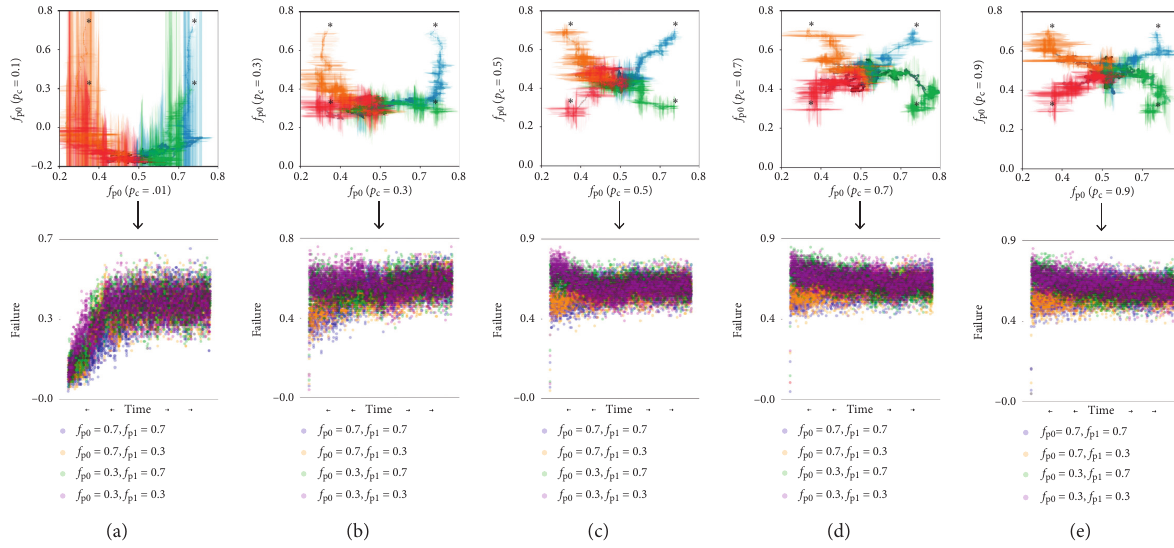
Figure 10: Patterns of evolution phenotypes obtained from the different starting point of the strategies with p (initialize parameters: nodes c n � 100, connection p � 0.1 ∼ 0.9, capital c � 1, f � 0.1, s � 100, p � 1, c � 0.1, p � 0.9, p � 0.05, μ � 0.0, σ � 0.0125, p � 0.1, p � 0.1, m p , max p , 1/2 r e n l � vertical axis, and t � 4000). The plots show their evolutionary trajectories with five observations including its variations ( f p0 � horizontal axis, dashed lines � coefficient of variation, dots � averaged value of the trait according to time step from the initial points; f p1 � 0.3, f � 0.7, blue: f � 0.7, f � 0.7, green: f � 0.7, f � 0.3, and purple: f � 0.3, f � 0.3). The plots of the bottom side orange: f p0 p1 p0 p1 p0 p1 p0 p1 represent the failure (vertical axis) according to time step (horizontal axis) with the different initial points of the